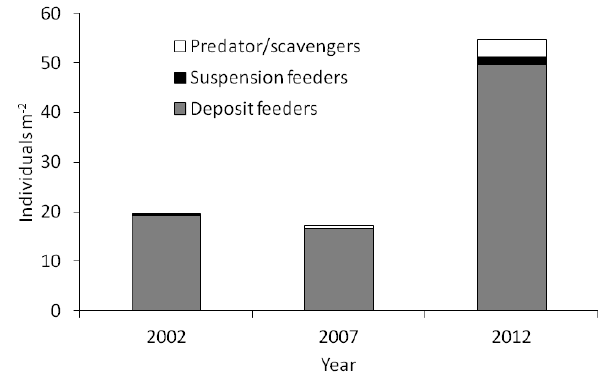
Fig. 5. Mean total density of megafauna and trophic groups in im- ages from 2002, 2007, and 2012 at HG I (based on 11 most reliably identified taxa). Differences in density of total fauna are significant between every pair of